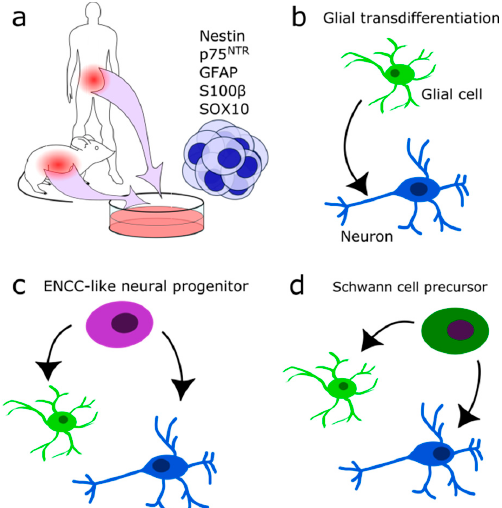
Figure 4. Suggested identities of multipotent neural progenitors. ( a ) Neurosphere-forming multipotent cells may be isolated from the intestinal system in human and mouse. ( b ) Glial cells may transdifferentiate into neurons directly after injury. ( c ) Adult ENCC-like neural progenitors with stem cell character may differentiate into neurons and glia during homeostasis and after injury. ( d ) Schwann cell precursor cells may differentiate into neurons and glial cells after injury. In contrast, Kulkarni and colleagues reported neuronal apoptosis and the occurrence of physiological neurogenesis in the adult mouse intestine [131]. NOS -expressing neurons were genetically labelled by the expression of tdTomato red fluorescent protein after ta- moxifen injection ( NOS1-creER T2 : dtTomato mouse line). Seven days later, new neurons were found lacking the tdTomato protein, indicating the formation of new neurons.